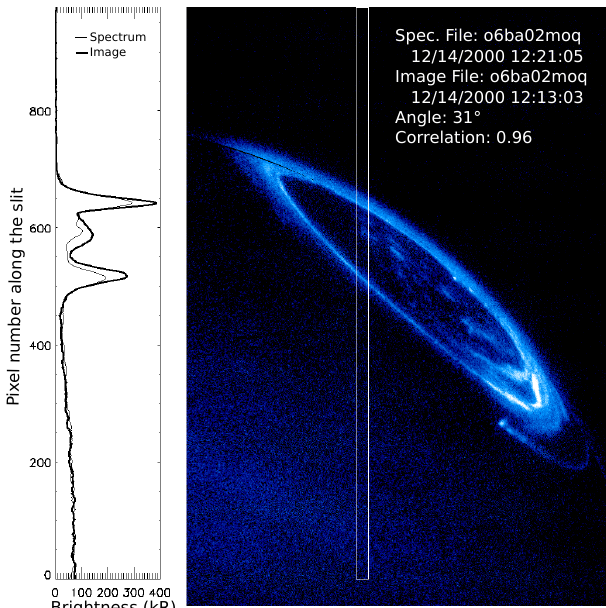
Figure 5. Example of a reconstructed STIS image corresponding to a spectral observation. The white rectangle represents the location of the slit. The spectral profile (thick line) versus the pixel number is shown on the side plot and the best fit profile from the reconstructed image is shown by the thin line. This image clearly shows that the slit is not normal to the limb and that any point on a profile along the slit mixes emissions from different altitudes.